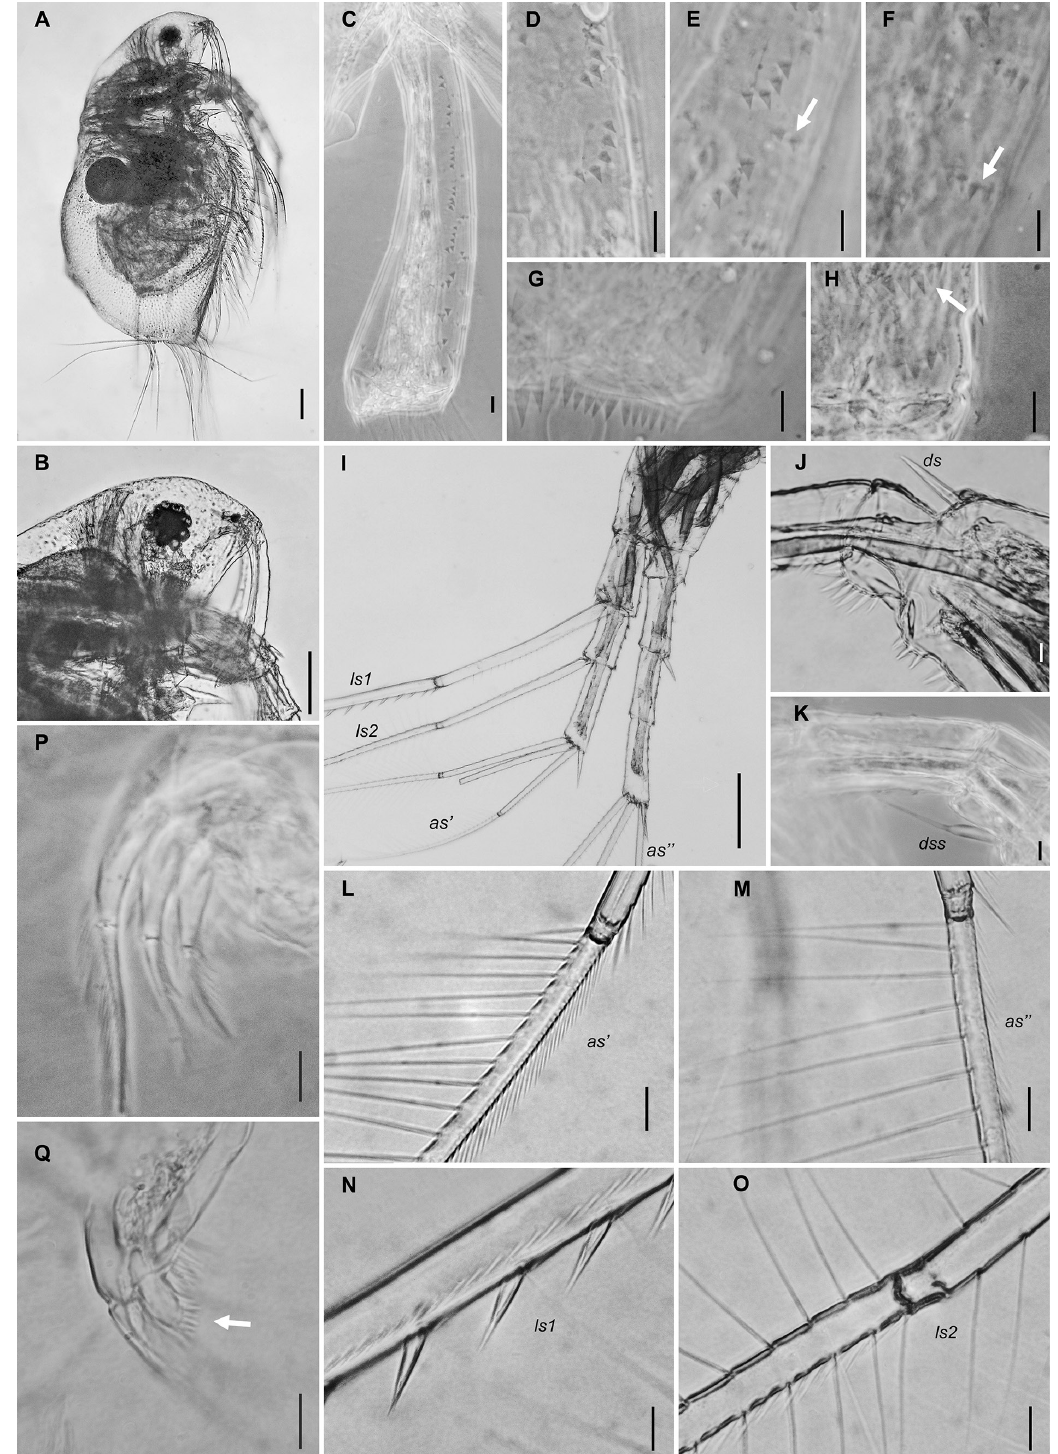
Fig. 5. Acantholeberis accolismaris Sousa, Elmoor-Loureiro & Álvarez-Silva sp. nov., parthenogenetic female from Jurubatiba National Park. A . Habitus. B . Head. C . Antennule. D–H . Antennule ornamentation (arrows show teeth organized in groups). I . Antenna. J–K . Antenna in lateral view, showing its base and first exopodite segment. L–O . Antennal setae. P–Q . Maxilla (arrow shows the short crown-like seta). Scale bars: A–B, I = 100 µm; C–H, J–Q = 10